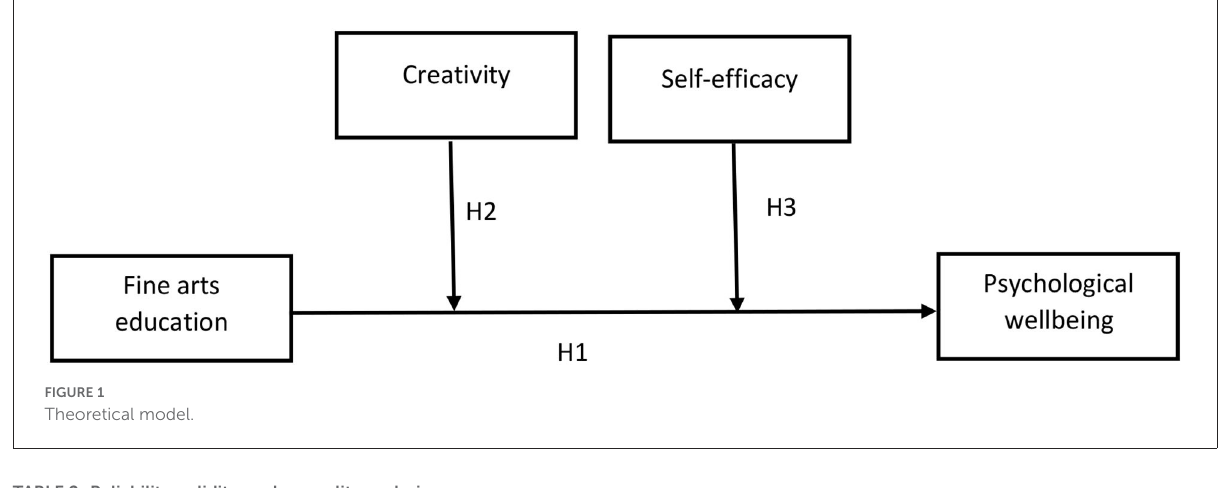
TABLE 2 Reliability, validity, and normality